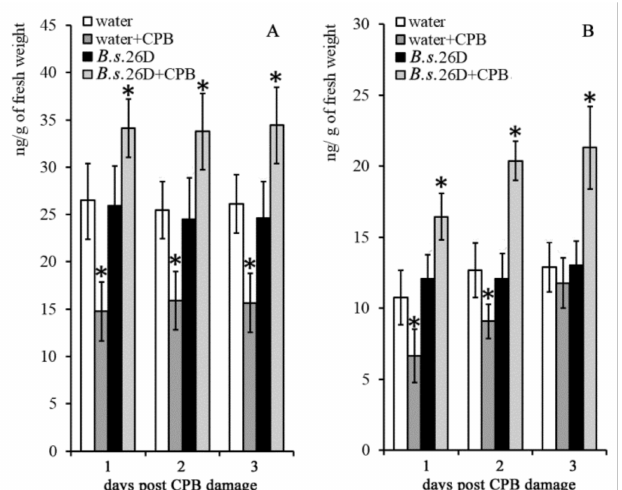
Figure 3. Influence of B. subtilis 26D on the level of IAA ( A ) and ABA ( B ) in potato plants on the 1st, 2nd and 3rd day after damage caused by CPBs. The values are means, and the vertical bars represent standard errors. Data analyzed using two-way ANOVA with Tukey’s post hoc test. Asterisks indicate means statistically different from the control at p ≤ 0.05. c—control plants (water-treated intact plants); CPB—plants damaged by Colorado potato beetle.